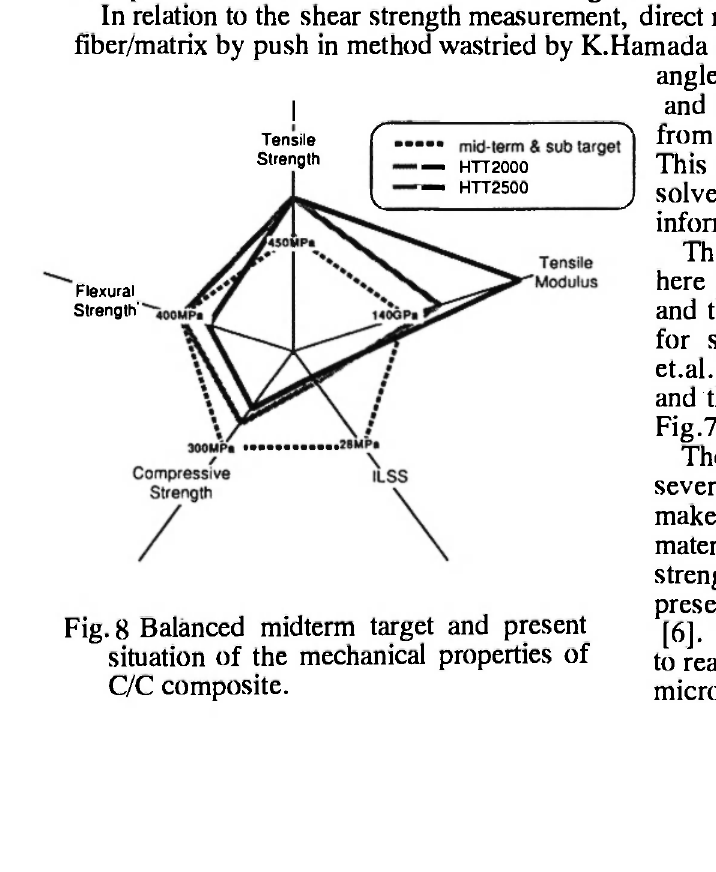
Fig. 8 Balanced midterm target and present situation of the mechanical properties of C/C